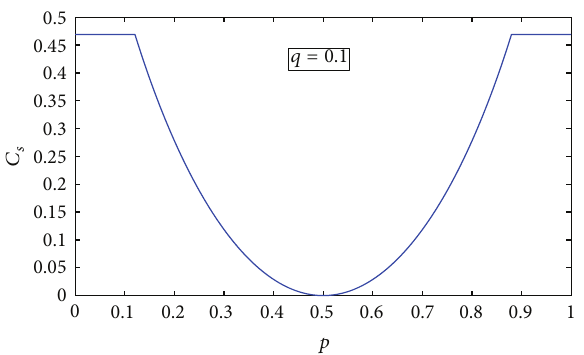
Figure 8: When 𝑞 = 0.1 , the secrecy capacity of the model of Figure 6 is with causal channel state information.